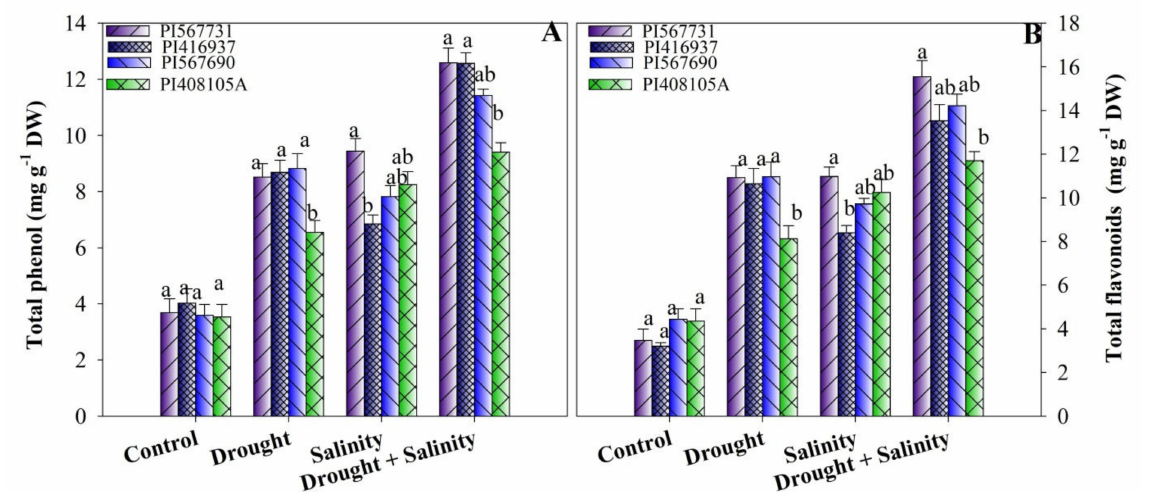
Figure 6. ( A ) Total phenols and ( B ) total flavonoids of four soybean cultivars grown under drought and salinity stress conditions. Data presented are means ± SD, and different letters denote a sig- nificant difference at p < 0.05 based on the least significant difference (LSD) test. Letter a is highly significant than b, and ab means no significant differences between a with ab and b with